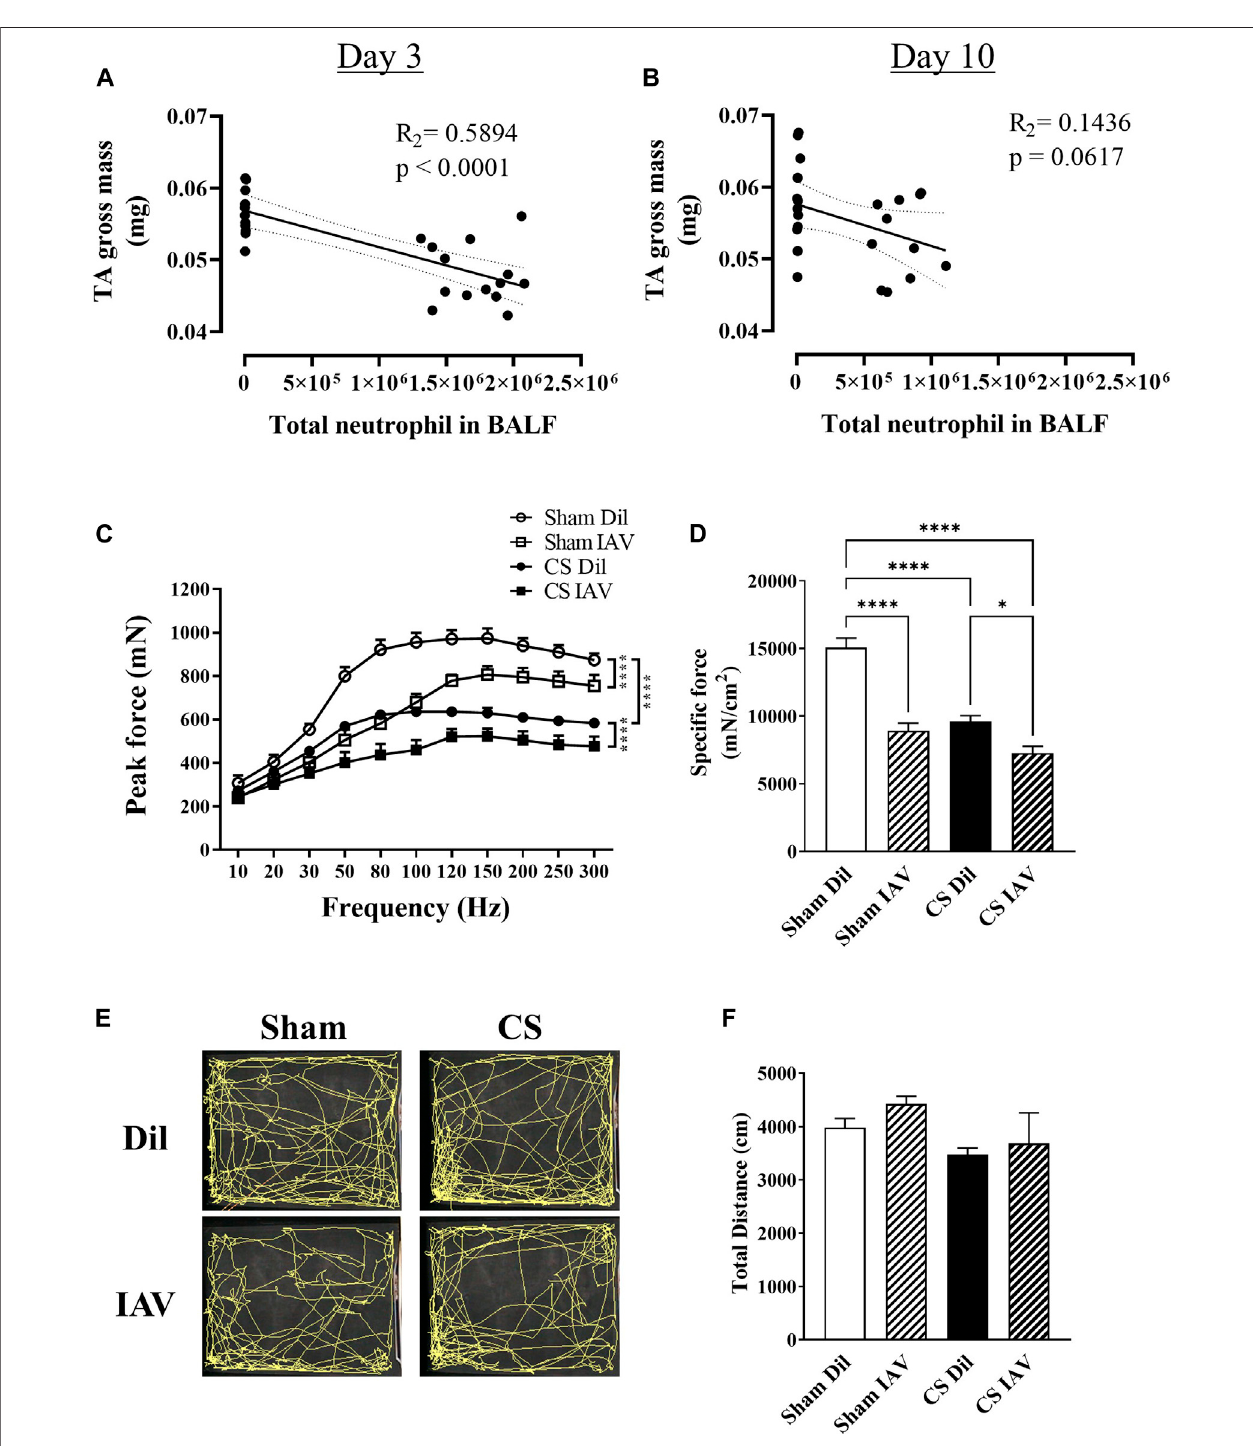
FIGURE 4 | Effect of CS exposure and in fl uenza A virus (IAV) infection on tibialis anterior (TA) muscle function. Correlational analyses of TA gross weight and total neutrophil counts in the BALF at (A) day 3 and (B) day 10 post IAV infection in CS-exposed and Sham mice. (C) Maximum contractile force and (D) speci fi c force at 120 Hzweredetermined atpeak ofairwayin fl ammation i.e., day3.Priortomusclefunctionalanalyses,recordingsweremadeoflocomotor activity over an8-minperiod and (E) trace maps were generated and analyzed for total distance travelled (cm). Data shown as mean +SEM ( n = 6 per group for correlational and TA contractile function analyses, and n = 10 per group for locomotor activity assessment). * p < 0.05, **** p < 0.0001.